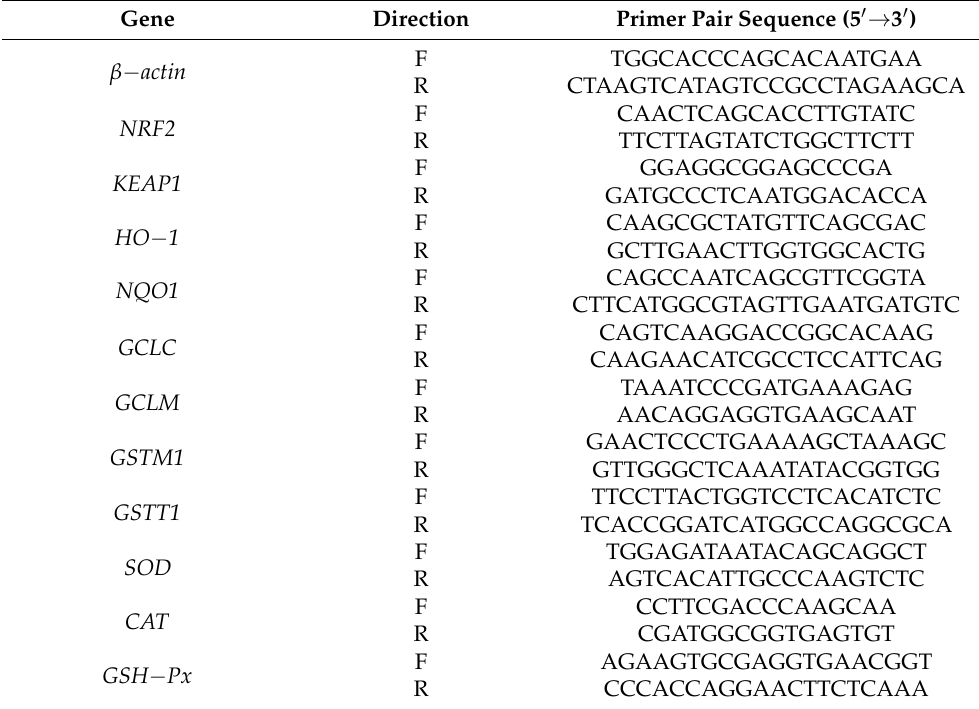
Table 1. Primer sequences for real − time